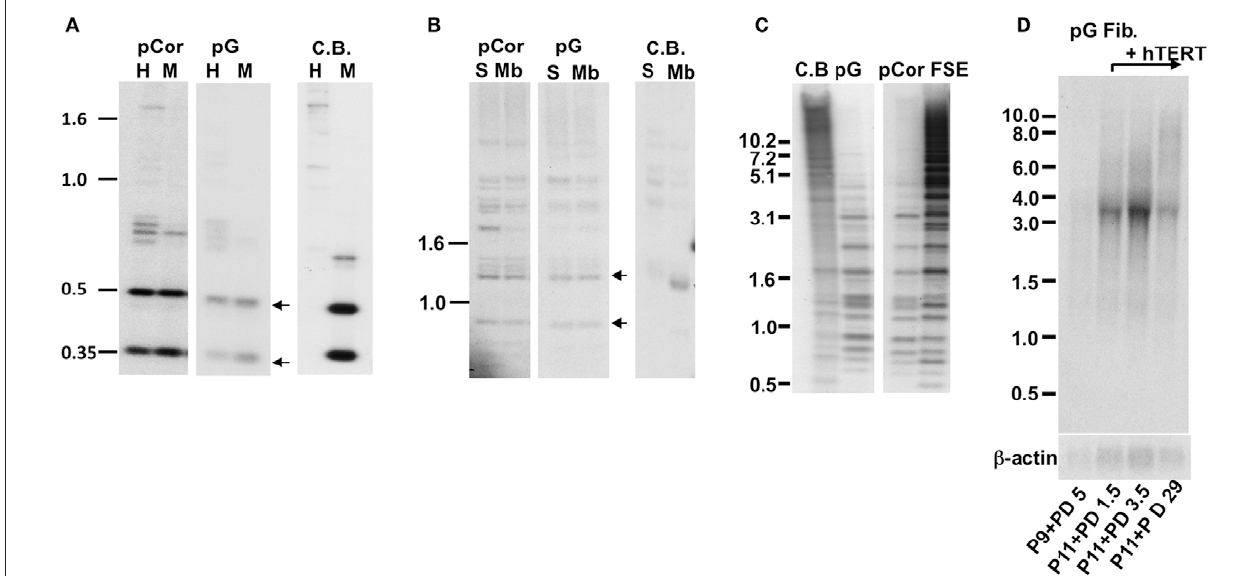
FIGURE 1 | pG fibroblasts display telomeric abnormalities typical to ICF type I syndrome. (A) Methylation analysis of subtelomeric repeats